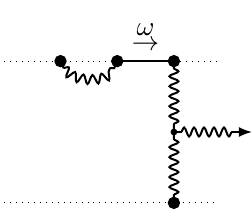
Figure 2. An example of a self-energy diagram, which does not appear in a three-body calculation at the same PM order. On support of the δ -function constraints we have ω = 0 , which gives rise to a singularity in the 1 /ω 2